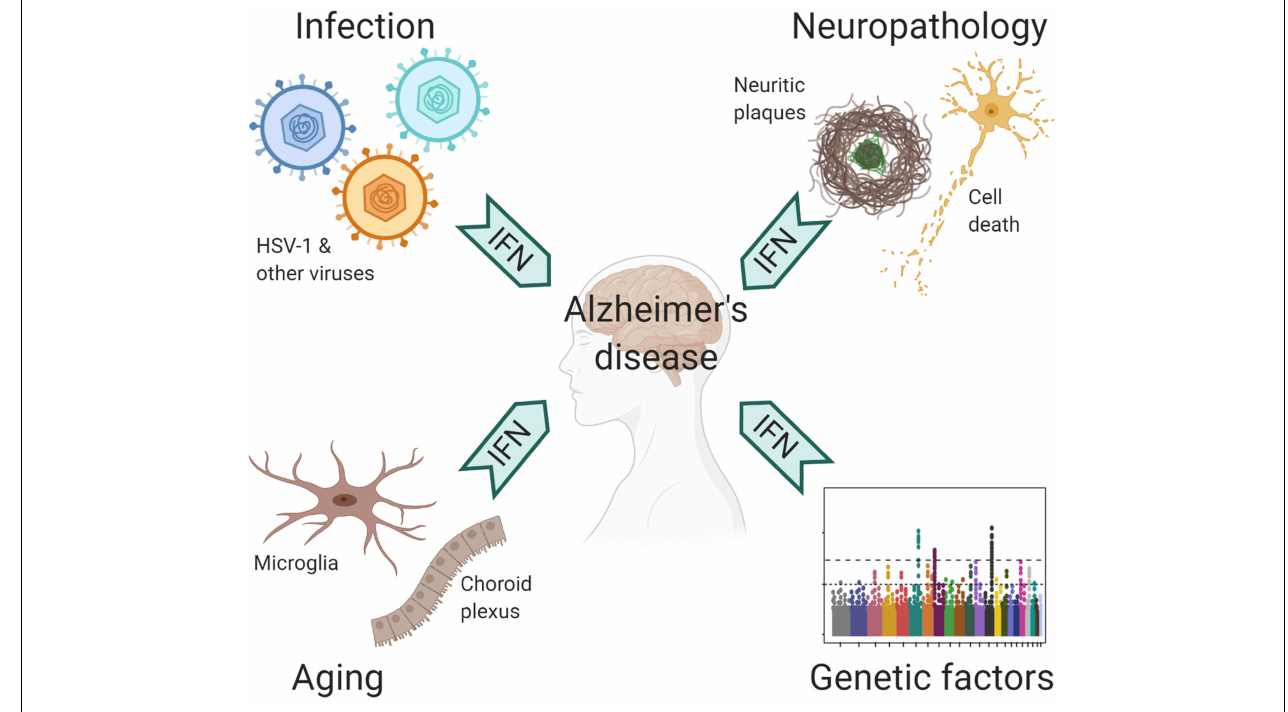
FIGURE 2 | Contributing factors to antiviral immune response in